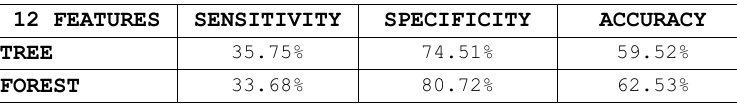
Table 17. One color slope value